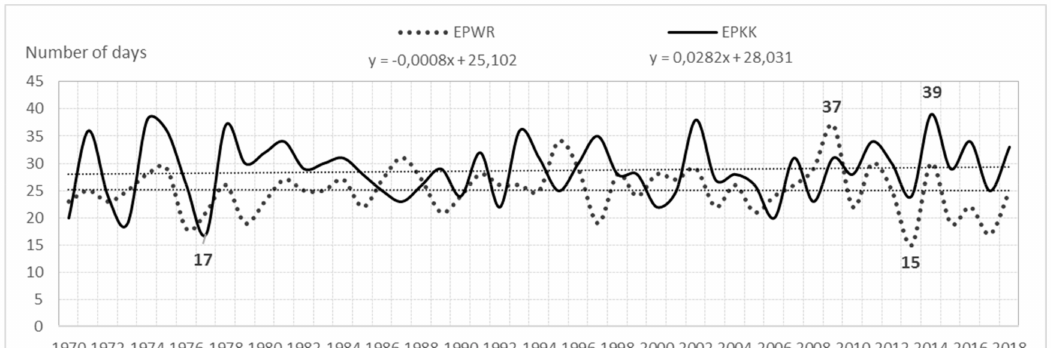
Figure 3. Average annual number of storm days and a linear trend in EPWR and EPKK (1970–2018). There were big di ff erences in the geographical distribution—storms were less frequent in the northern part of the studied area and in the Baltic coast area than in southern Poland. The average annual number of days with a storm ranged from 17 in EPGD to 29 in EPKK (see Figure 4). The maximum average annual number of days with a storm ranged from 28 in EPGD to 39 in EPKK.